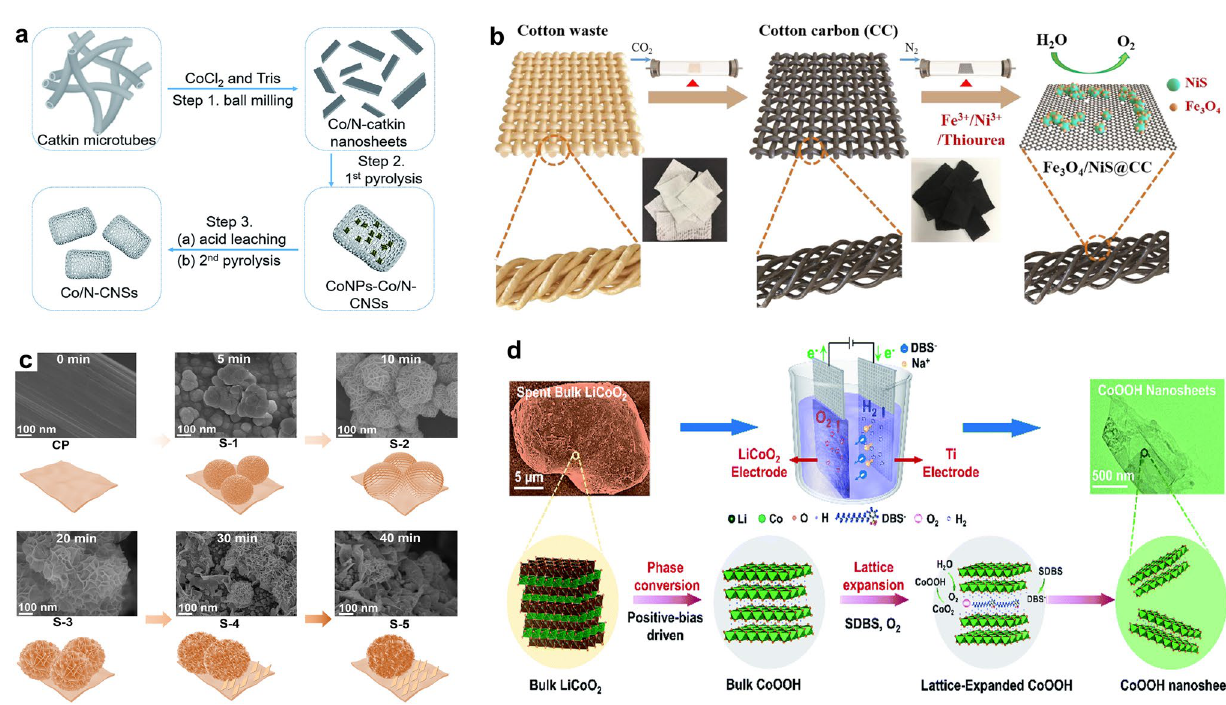
Fig. 3 a Illustration of synthesis of Co/N–CNSs catalysts [73]. Copyright 2020, Royal Society of Chemistry. b Scheme of the preparation of